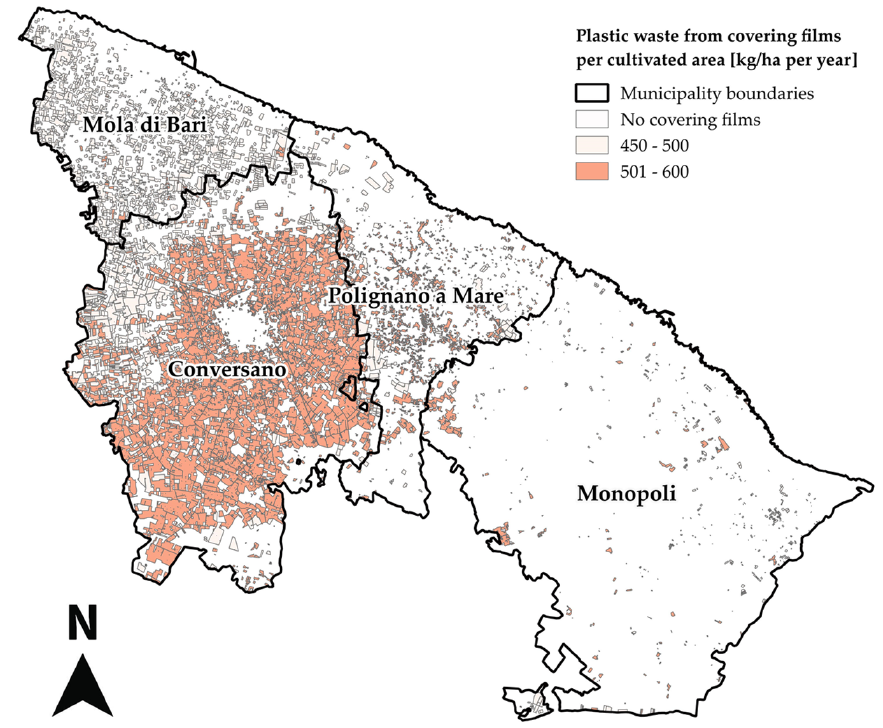
Figure 8. Distribution of the APW from covering films in the four municipalities in the scenario of longer lifespans (1st scenario).